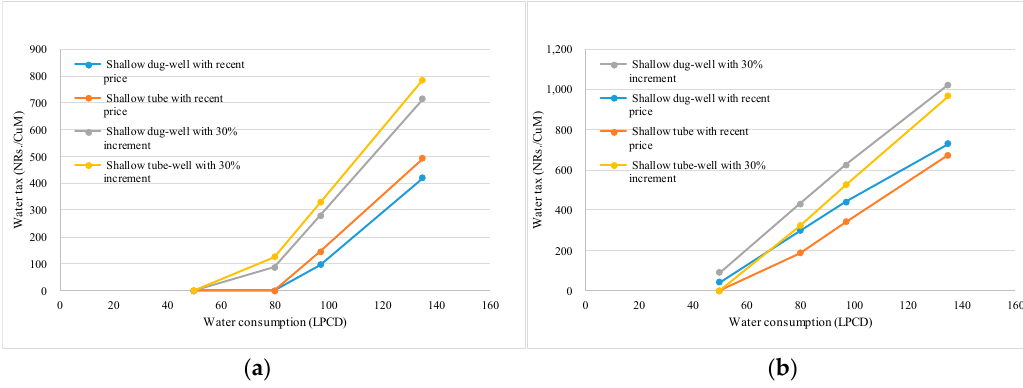
Figure 4. Taxation requirements with different water consumption scenarios (NRs/month).